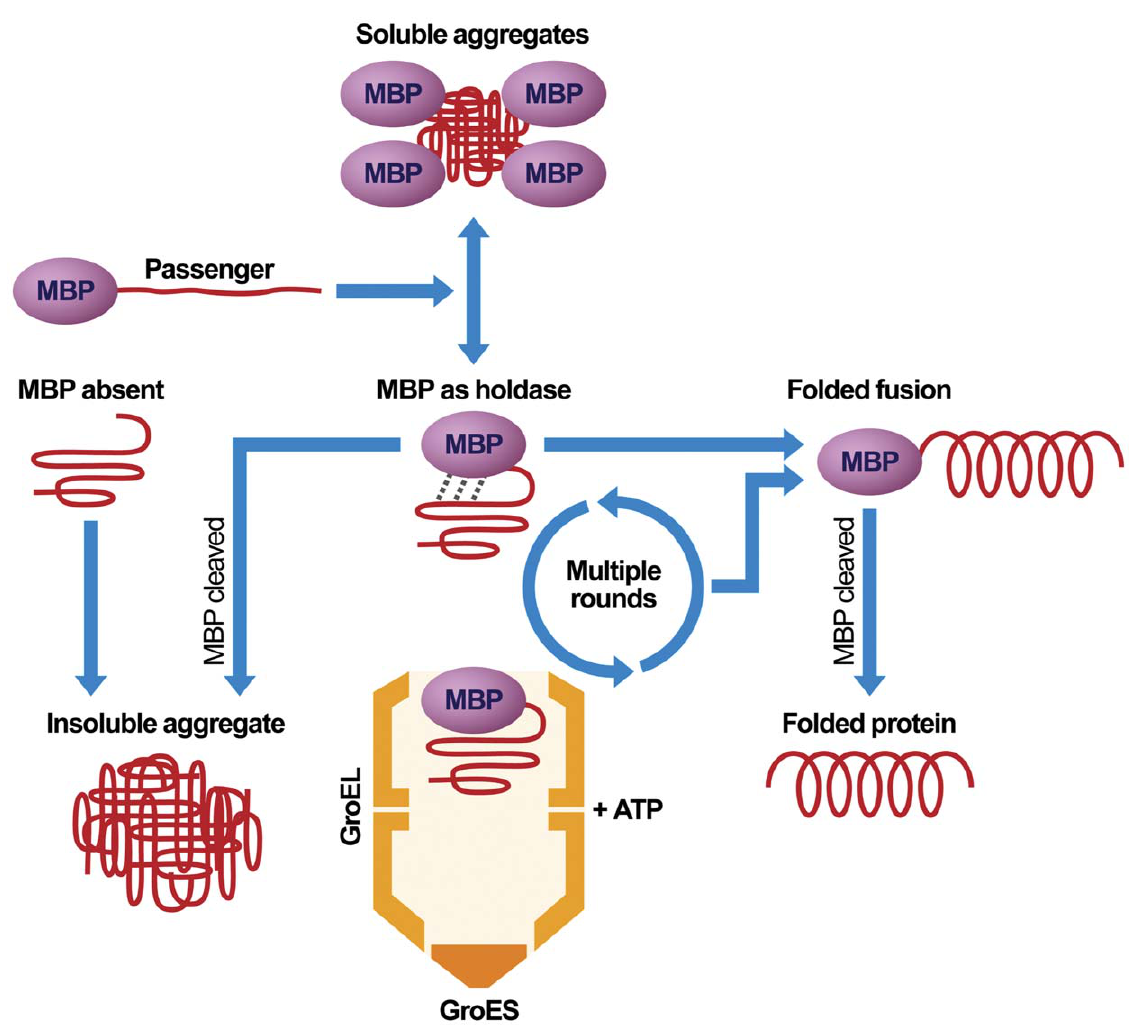
Figure 7. A model illustrating the roles that MBP plays in the production of recombinant proteins (see text for discussion). Figure S1 Copurification of GroEL with natively puri- fied MBP fusions on an affinity (IMAC) column. (A) Western blot using anti-GroEL antibody. Lane 1, His 6 -MBP- G3PDH; lane 2, His 6 -MBP-DHFR; lane 3, His 6 -MBP; lane 4, purified GroEL. (B) SDS-PAGE analysis of the above samples (loading same as above). (TIF)